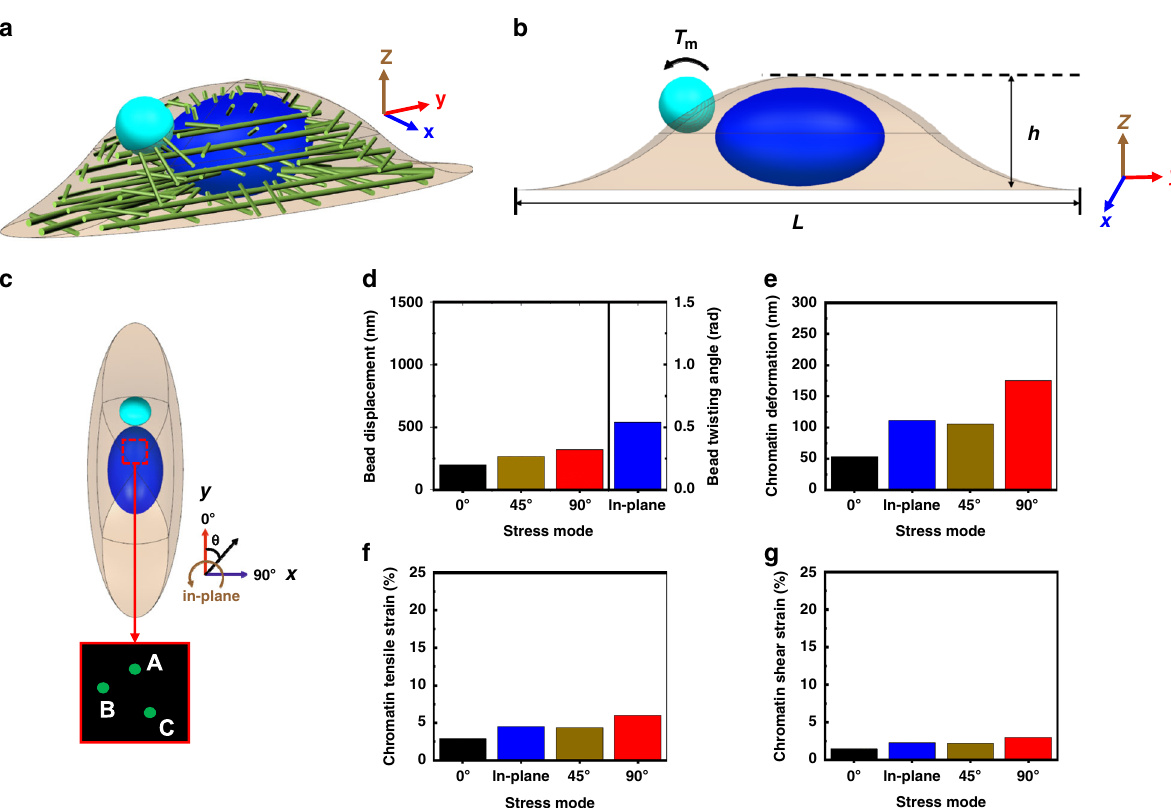
Fig. 5 Finite element models (FEM) reveal anisotropic responses of the cell. a A 3D illustration of the location of bead and spatial arrangement of the nucleus and actin stress fi bers in the FEM model of the cell – bead system: the magnetic bead is in light blue, the nucleus is in dark blue, the cytoplasm is in light brown, and the cell cortex is in brown. Not drawn to scale. b The cross-sectional illustration of cell – bead system, showing the dimension of the cell, nucleus, and the bead (see Methods section). The speci fi c torque T m (applied stress of 15 Pa) was applied on the cell via the bead. We estimated various parameter values for different components of the cell, obtained from the published report 43 . The Young ’ s moduli of cell membrane cortex, cytoplasm, and nucleus were 2, 0.25, and 1.0 kPa, respectively; Poisson ’ s ratios of cell membrane cortex, cytoplasm, and nucleus were 0.3, 0.49, and 0.3, respectively; the actin stress fi ber ’ s stiffness was 20 nN μ m − 1 . c Illustration of application of load for each stress mode, where theta represents the angle between the rolling direction of the magnetic bead and the long axis of the cell, and the magni fi ed view of the boxed area of nucleus illustrating the three points for calculating the chromatin deformation. d Magnetic bead displacements and rotation angle. e Chromatin deformation. f Chromatin tensile strain. g Chromatin shear